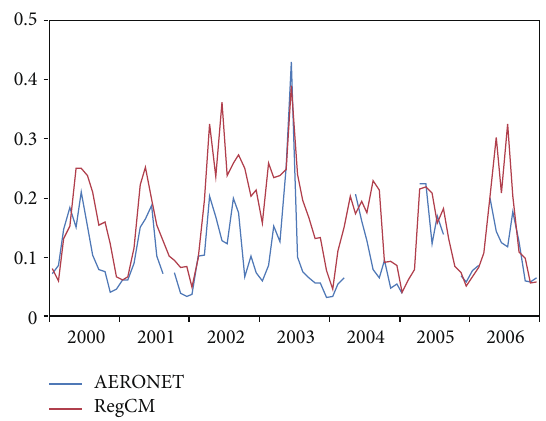
Figure 4: Variations of monthly mean AOD at Dalanzadgad from AERONET observations (500 nm) and that near the grid of Dalanzadgad simulated by the